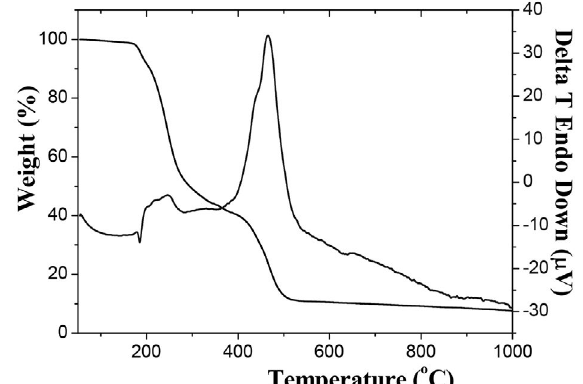
Figure 5. DT-TGA curve of 1 .